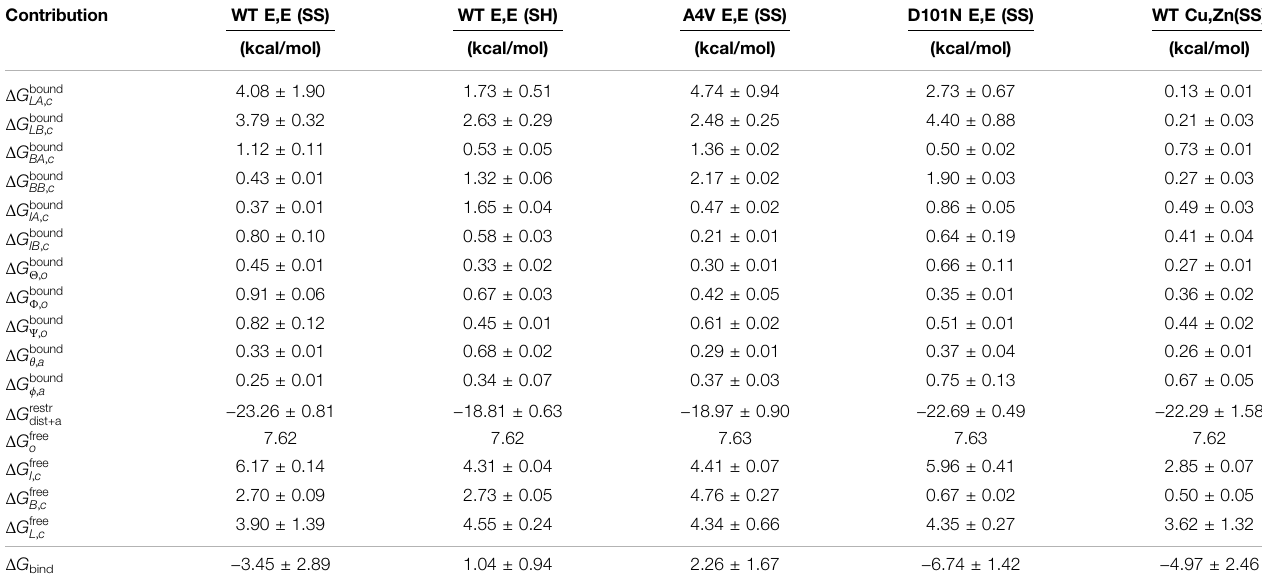
TABLE 1 | Free energies associated with the contributions to the binding free energy Δ G bind .